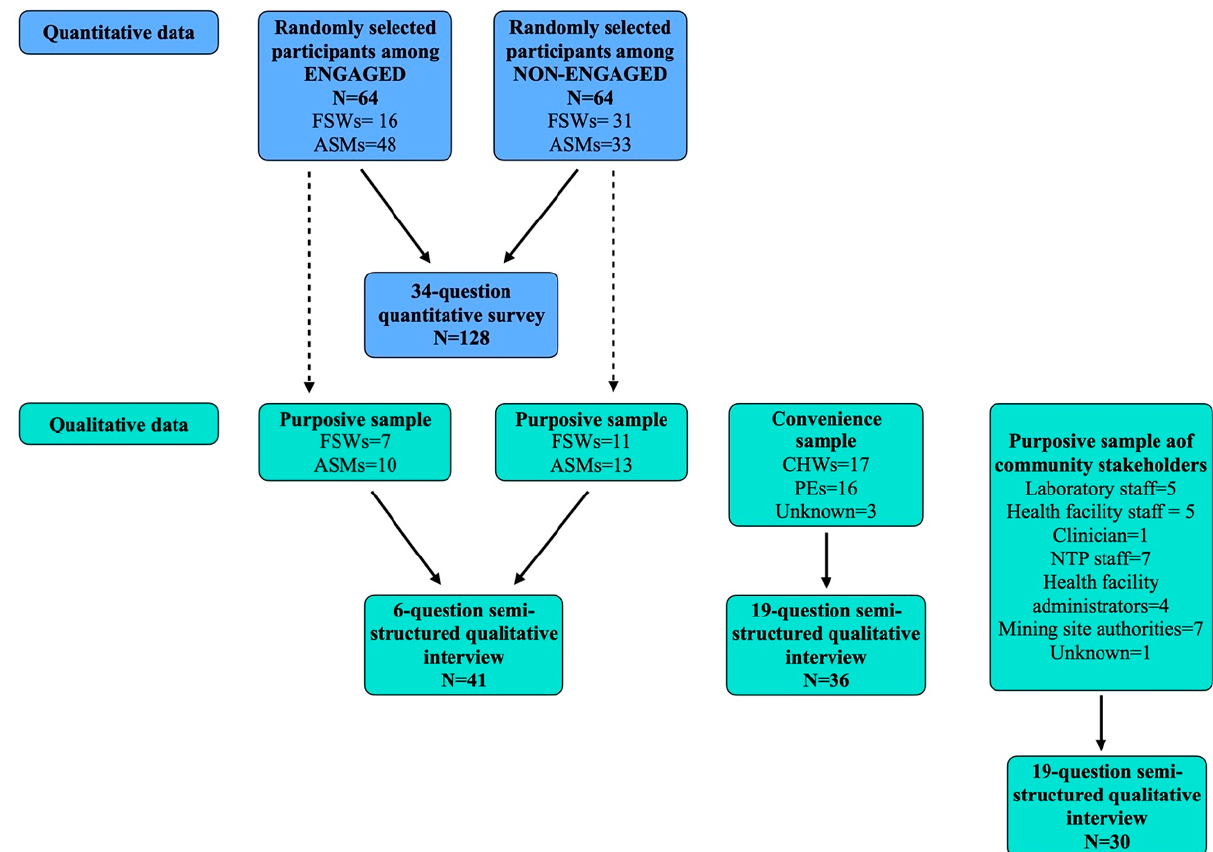
Figure 1. Sampling for quantitative and qualitative data collection .